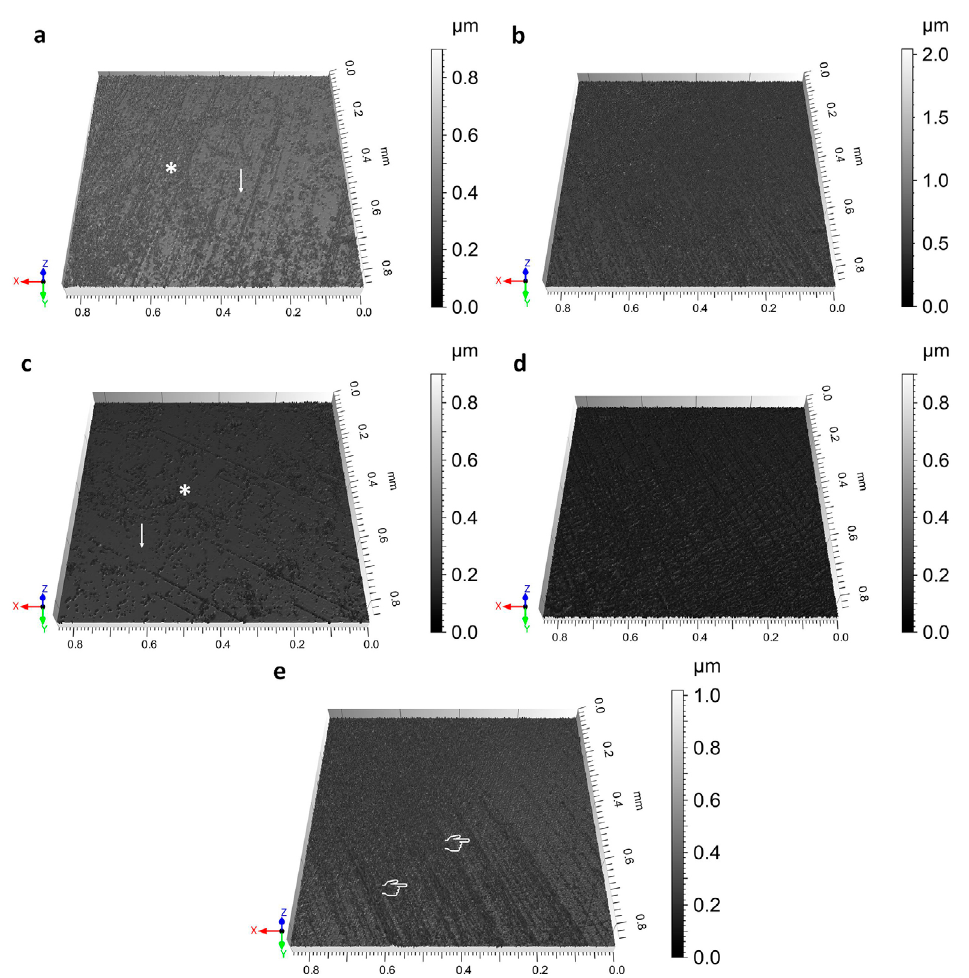
Figure 2- Surface topography of enamel by optical profilometer after application of agents and cariogenic challenge: (a) chitosan nanoparticle suspension; (b) Chitosan; (c) 0.05% NaF and (d) Distilled water (control). Figures a and c show uneven roughness (*) interspersed with smooth enamel areas (↓). Figures b and d depict homogenous and uniform roughness over the entire enamel surface. (e) The sound group shows the presence of some scratches from the specimen polishing ( ?